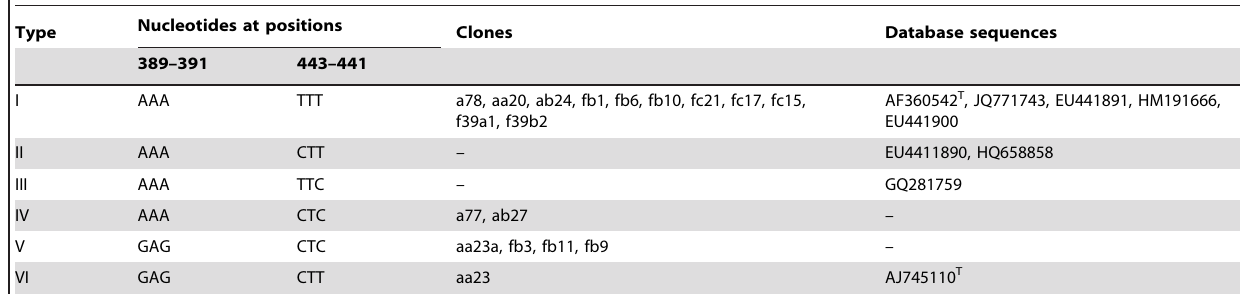
Table 5. Compensatory nucleotide substitutions in VR2.